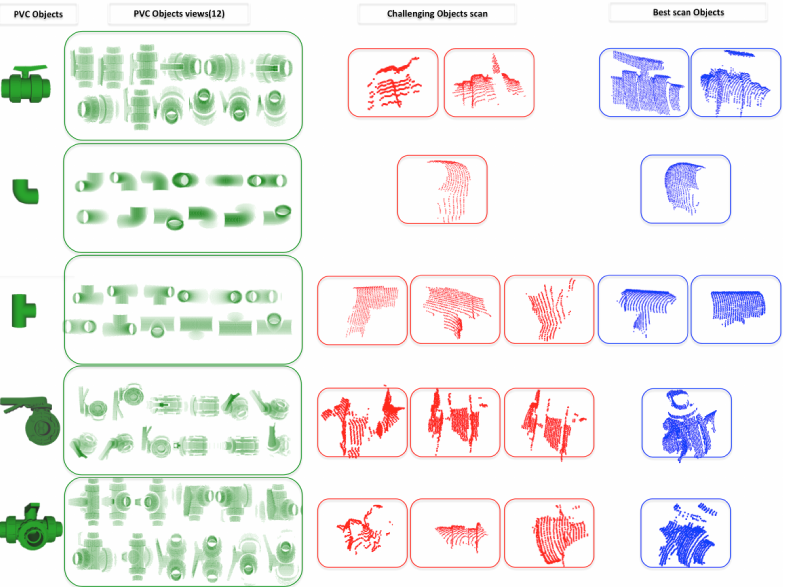
Figure 15. PVC objects used in the experiment (first column) with their respective database views (second column). The last two columns provide manually selected examples of segmented objects from the experiments, with the most difficult in red and the easiest in